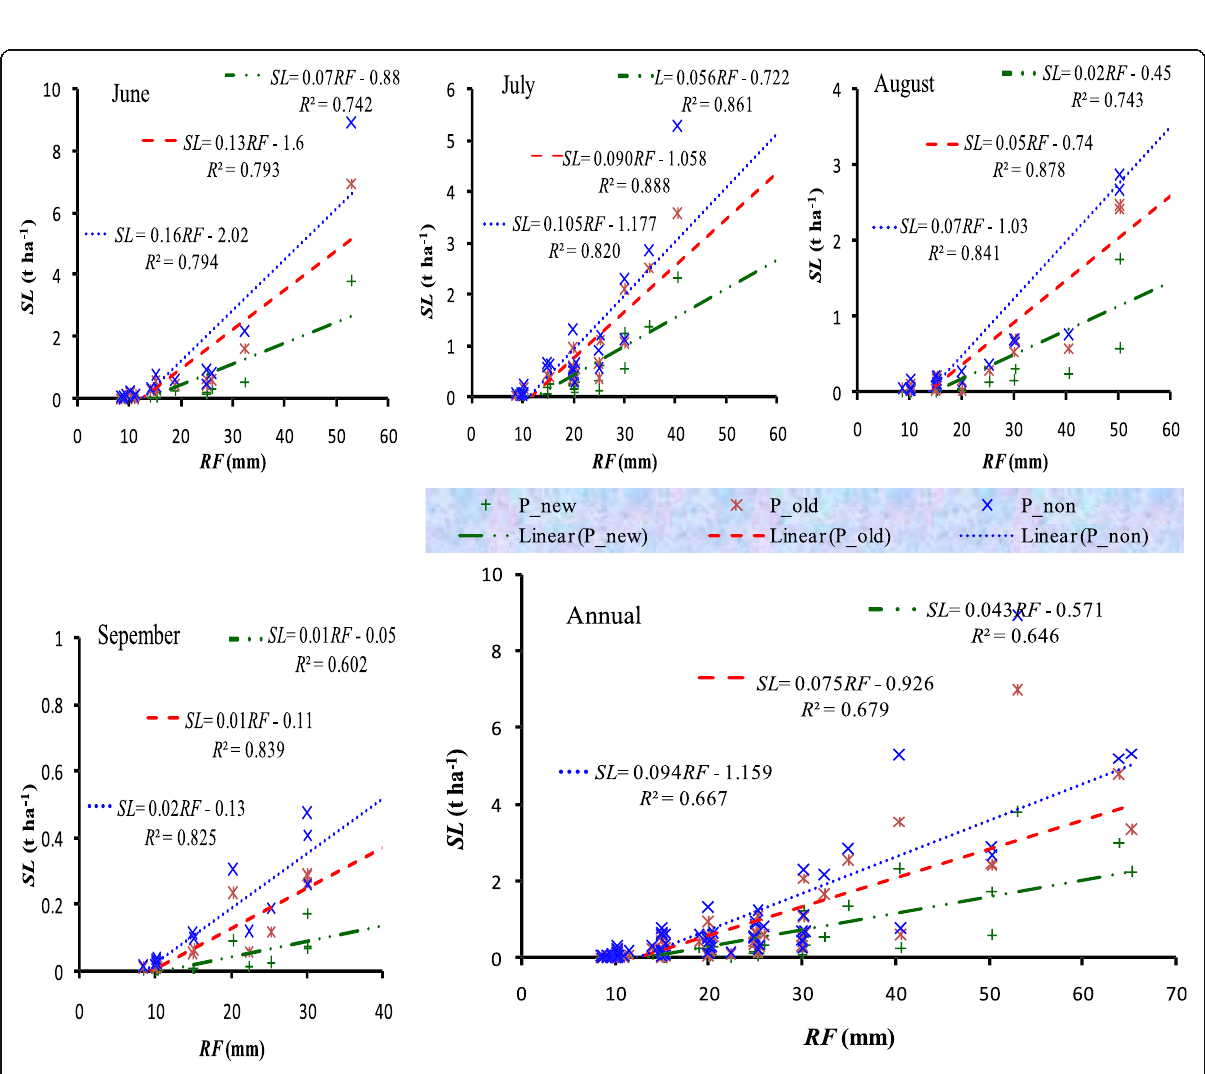
Fig. 7 Rainfall-sediment loss relationship within plots treated with new soil bund, old soil bund, and